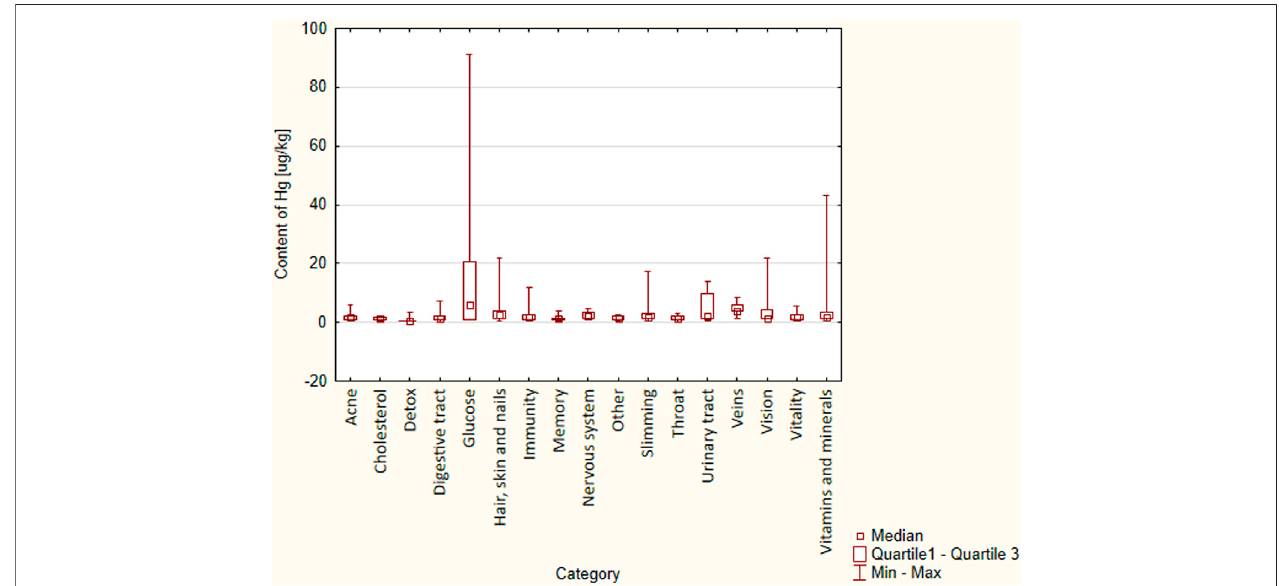
FIGURE 1 | Differences in Hg content between the category of DS ( p (cid:1) 0.068, results were not statistically signi fi cant).